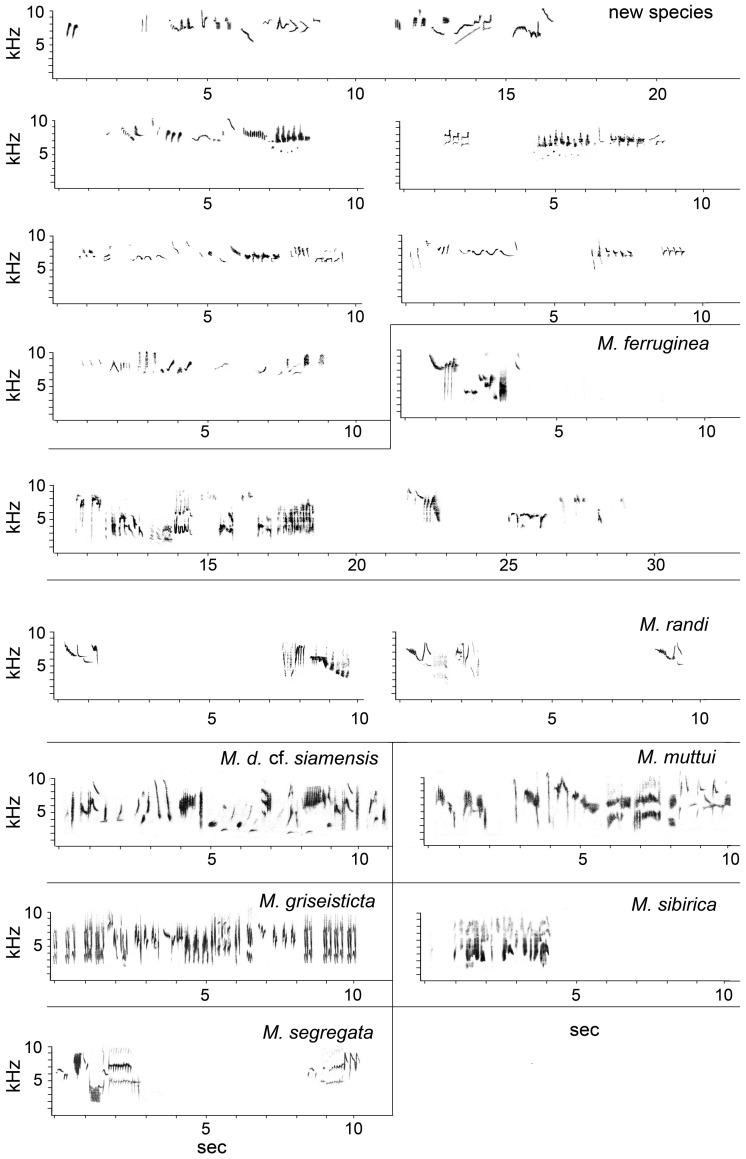
Sonagrams of the new species and related Asian taxa.Localities, recordists, and catalog number (if any): new species, Baku Bakulu, Sulawesi, P.C.R./J.B.C.H., AV17423–17428; successive strophes from the same individual; M. ferruginea, Nantou, Taiwan, S. Severinghaus, ML 13910; M. randi, Hamut, Luzon, B. Demeulemeester, AV 14197, 14368; M. d. cf. siamensis, Cambodia, D. Farrow, XC 49755; M. muttui, Kandy, Sri Lanka, D. Warakagoda, AV 6672; M. griseisticta, Russia, B. Veprintsev, ML 100139; M. s. sibirica, H. Ueda; M. segregata, Sumba, J. Eaton.